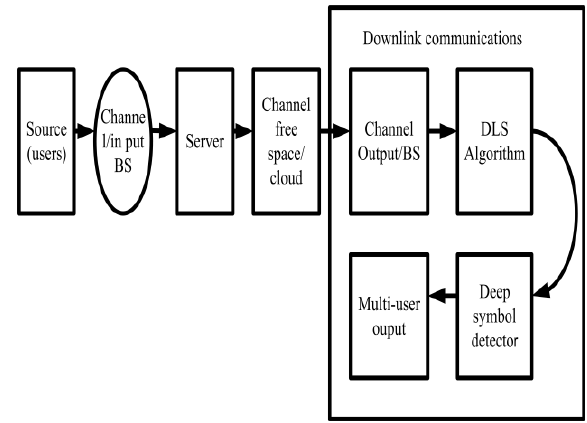
Figure 5 . Communication from Source to